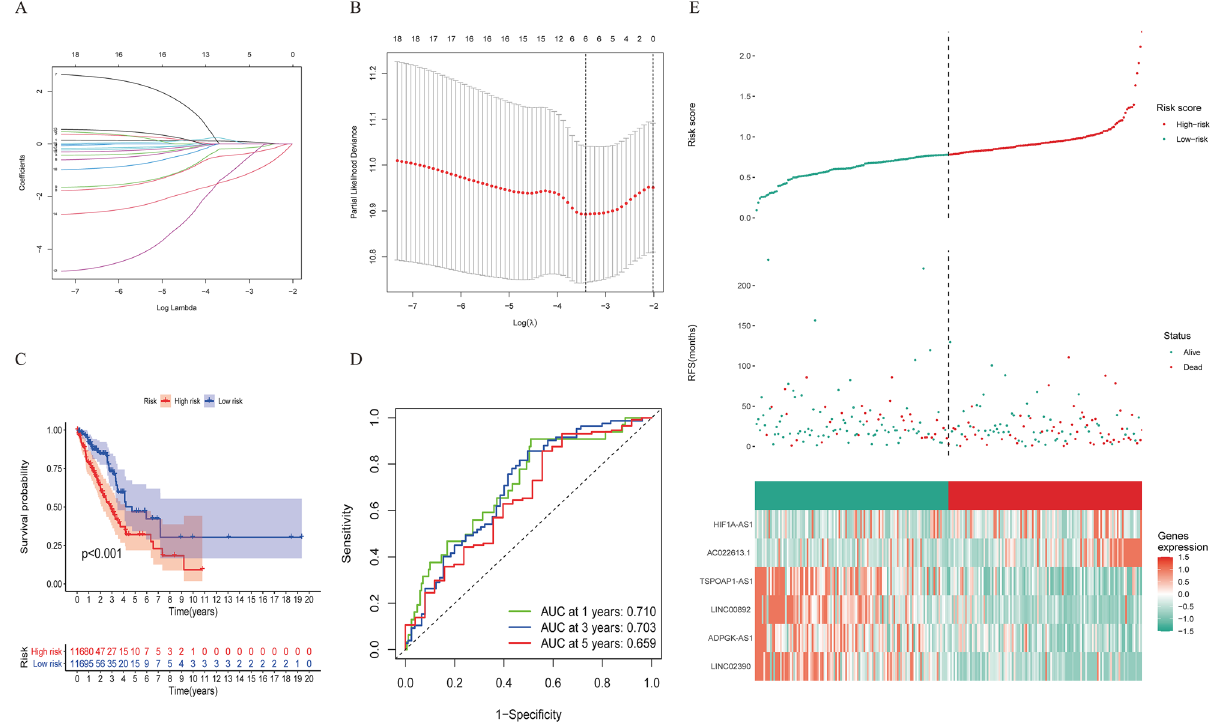
Figure 4. A risk model for LUAD patients based on IClncRNAs. ( A ) The LASSO coefficient profile of 18 OS-related lncRNAs. The perpendicular imaginary line is drawn at the value chosen by tenfold cross-validation. ( B ) The tuning parameters (log λ) of OS-related proteins were selected to cross-verify the error curve. According to the minimal criterion and 1-se criterion, the perpendicular imaginary line is drawn at the optimal value. ( C ) Kaplan–Meier survival curves of OS of patients in the high- and low-risk groups. ( D ) The time ‐ dependent ROC analyses of this model in the training cohort. ( E ) The distribution of risk scores based on the IClncRNAs, vital statuses of the patients sorted by risk score and the six-lncRNA expression heatmap in the training